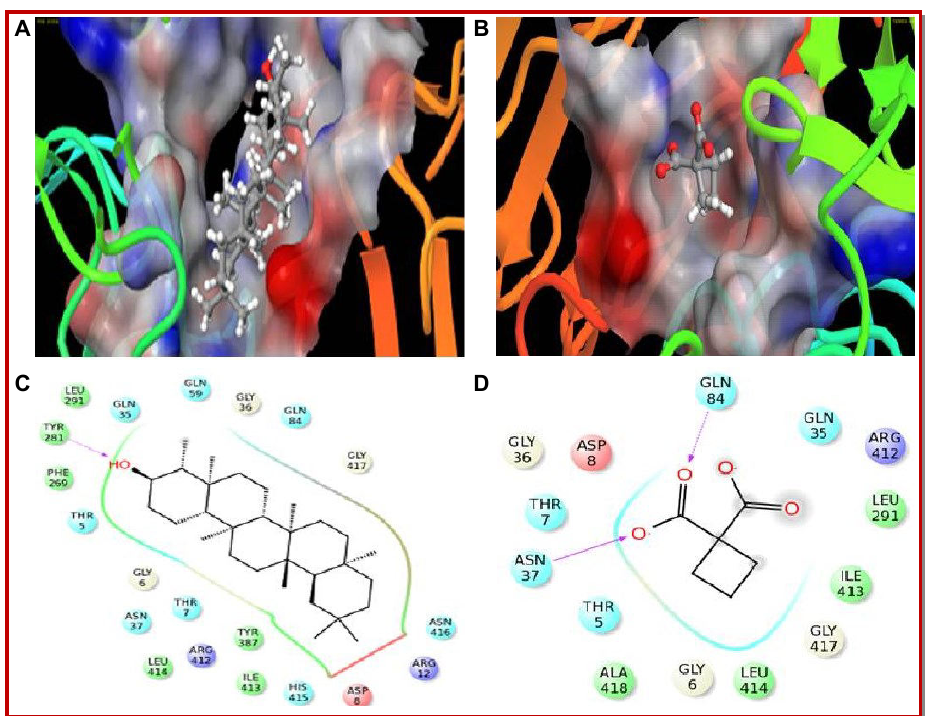
Figure 2: Docking complexes of HER2 with (A) epifriedelanol and (B) carboplatin generated by using Glide-XP module of Schrodinger suite are shown in this figure. The proteins, ligands and binding pockets are represented in ribbon, sticks and surface models, respectively. Residues of the HER2 that are within 4 Å proximities to the (C) epifriedelanol and (D) carboplatin are illus- trated in 2D graphics. Dotted lines denote ‘Hydrogen bonds’ between the corresponding